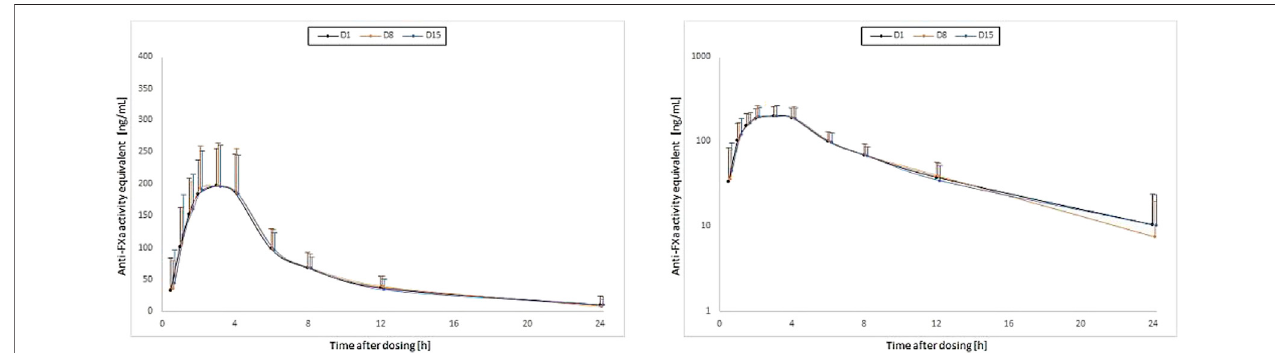
FIGURE3| Timecoursesoftheanti-FXaactivity(means,standarddeviations;left:linearaxis;right:log-linearaxis)forsingledosesof20 mgrivaroxabanatbaseline (Day1[D1])andconcomitantlywiththe fi rst(Day8[D8])andthelastdose(Day15[D15])ofa1 weektreatmentwithonce-dailydosingof240 mgEGb761 ® in41healthy